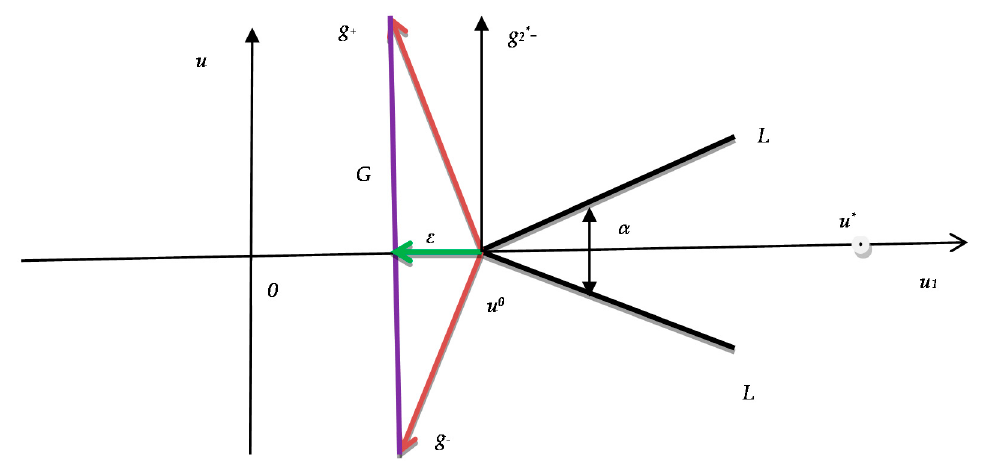
Figure 1. Gradients for adjacent half-planes.